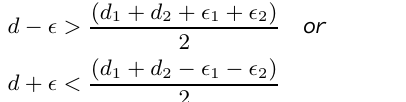
figure 3. Note that vertices not representing actual structure but local noise can be